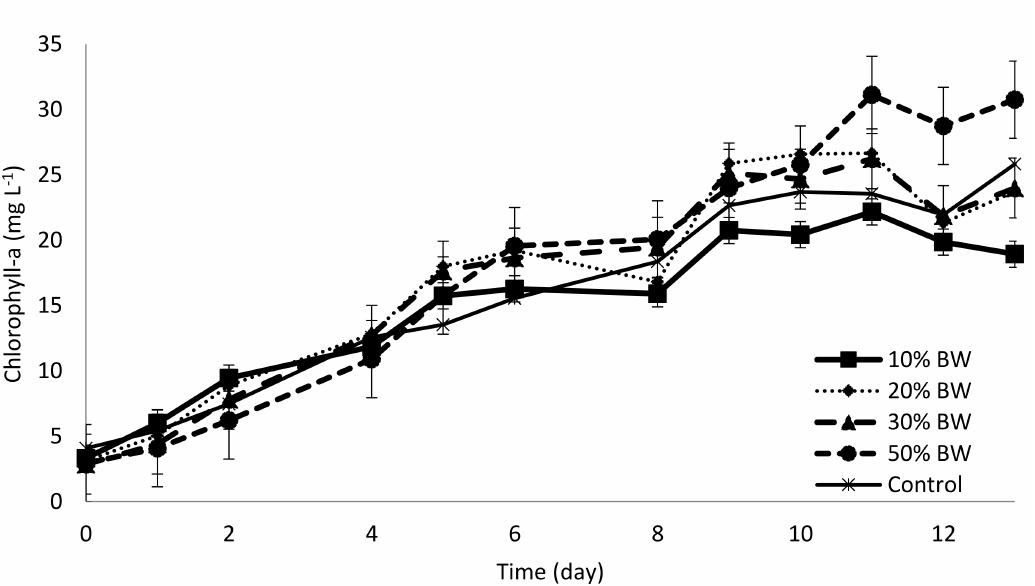
Figure 1. Concentrations of chlorophyll-a in di ff erent dilutions of blackwater (BW) ( n =